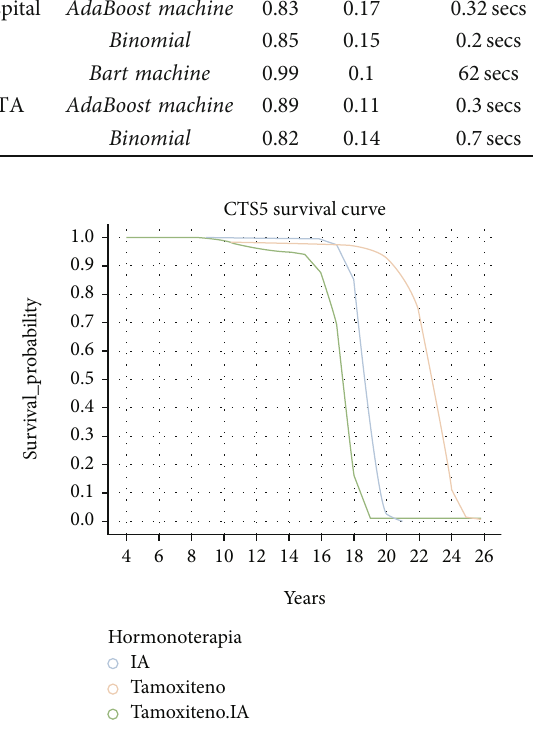
Figure 1: Interface preview ( ∗ CTS5 refers to the Hospital